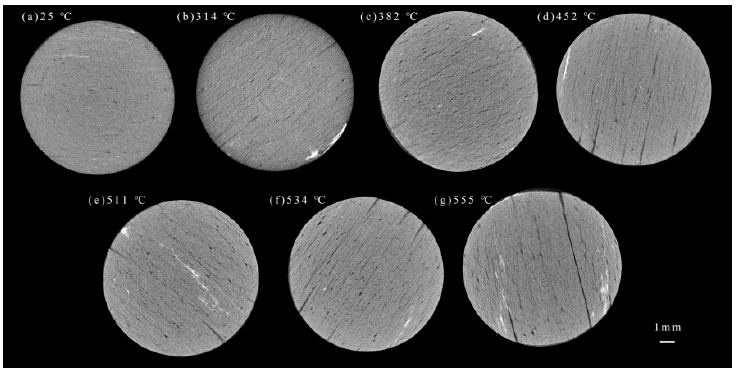
Figure 4. Representative CT slices of the seven samples: ( a ) 25 °C; ( b ) 314 °C; ( c ) 382 °C; ( d ) 452 ° C ; ( e ) 511 °C; ( f ) 534 °C; ( g ) 555 ° C .